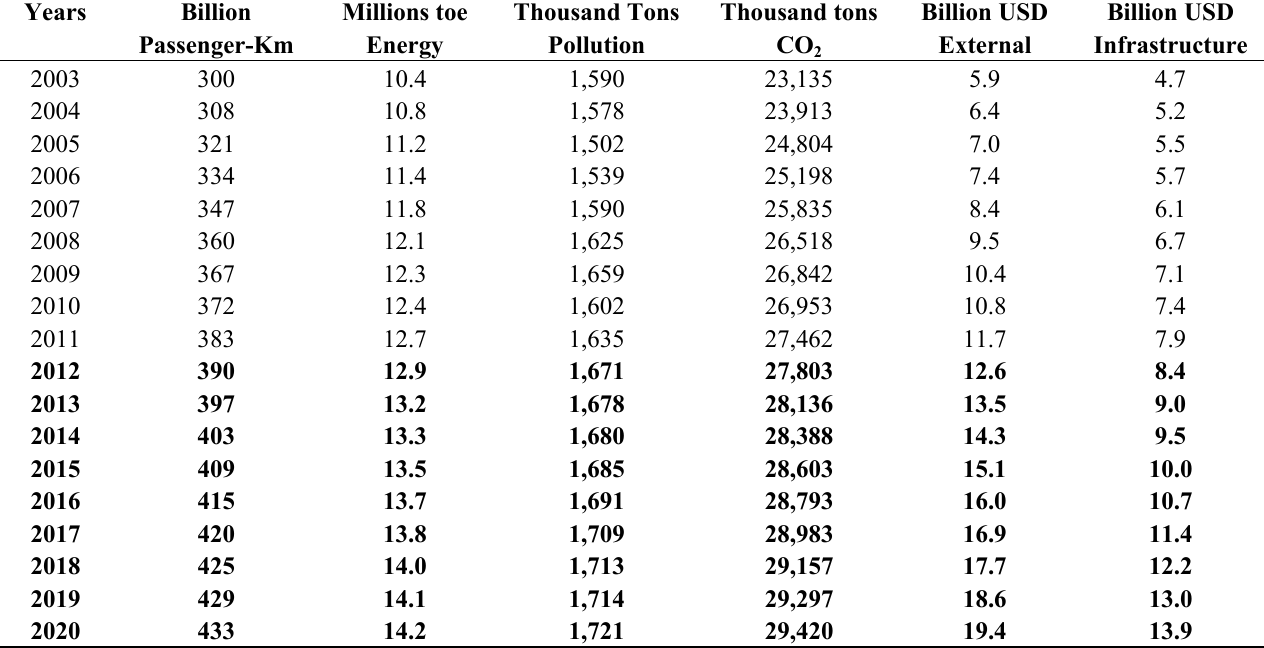
Table 8. Projection of transportation demand and external costs up to